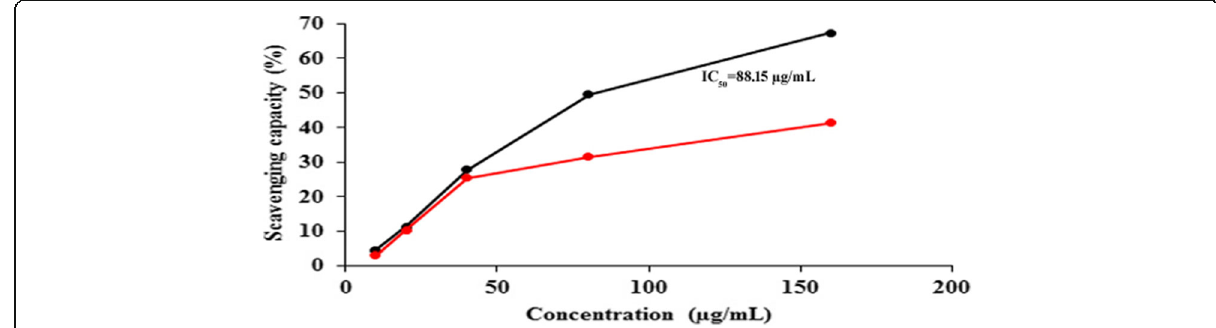
Fig. 8 Nitric oxide scavenging capacity of poly herbal formulations: PHF1 (black) and PHF2